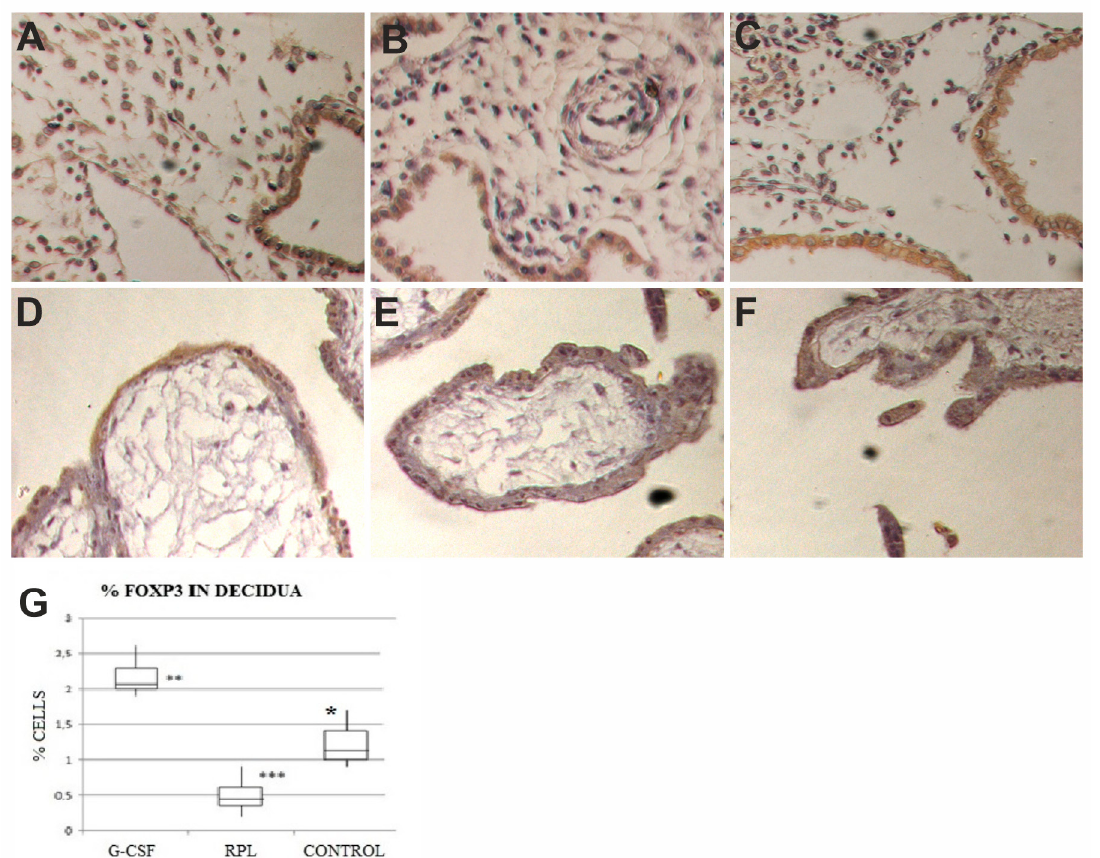
Figure 1. In decidua of Granulocyte Colony Stimulating Factor (G-CSF) treated samples ( A ), in the stroma there was a remarkable increase in the number of Foxp3 cells with respect to other two groups, epithelial cells showed a moderate staining (brown color) (400×). In decidua of no treated Recurrent Pregnancy Loss (RPL) samples ( B ), in the stroma there was a strong reduction in the number of Foxp3 cells, epithelial cells showed a moderate staining (brown color) (400×). In decidua of control samples ( C ), in the stroma there was a number of cells positive to Foxp3 cells, higher than in no-treated RPL and lower than in G-CSF treated samples, epithelial cells showed a moderate staining (brown color) (400×). The graph ( G ) showed percent of immunohistochemical positive cells in the stroma to Foxp3 (charts display median and quartiles with whiskers showing the range): There was a statistically significant difference between G-CSF vs. RPL (* p < 0.001), G-CSF vs. Control (** p < 0.01) and RPL vs. Control (*** p < 0.01). Foxp3 expression in decidua and trophoblast of first trimester pregnancy. In trophoblast of GCS-F treated group ( D ), no treated RPL ( E ) and Control ( F ) there was no staining at all for Foxp3 (400×).